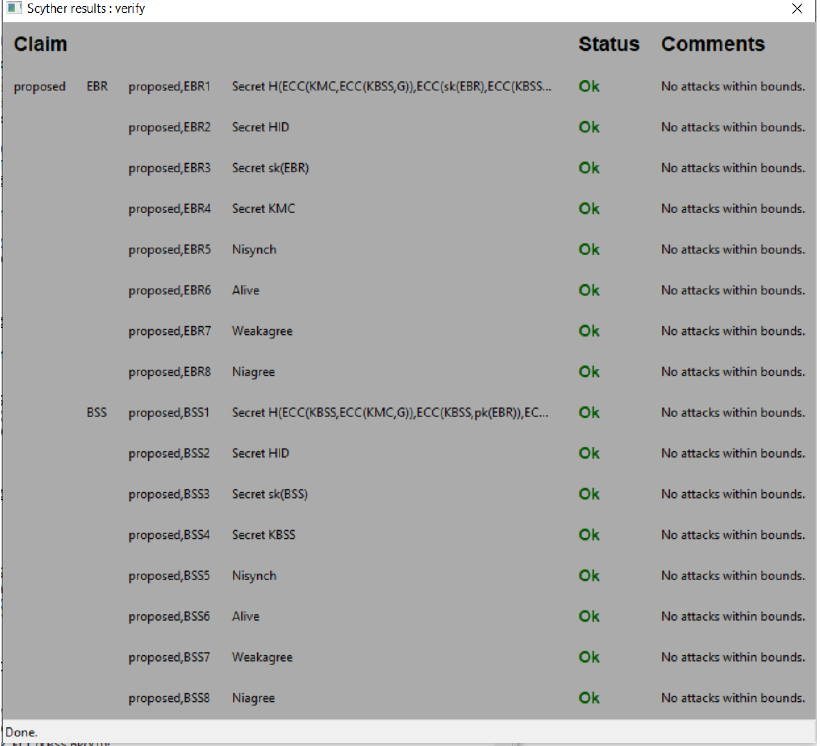
Figure 5. Security verification results of LLAKEP + on